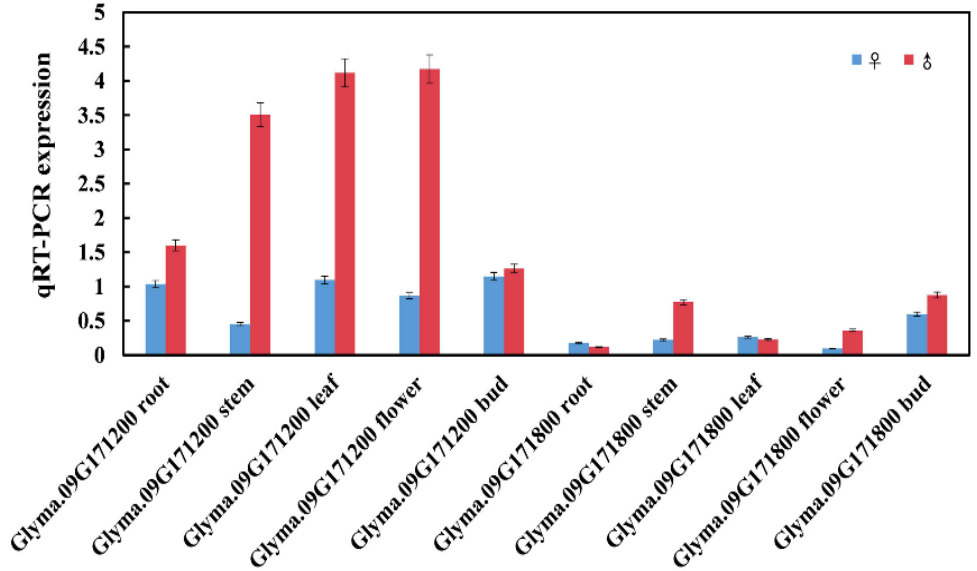
Figure 6. Gene expression analysis of Glyma.09G171200 and Glyma.09G171800 by